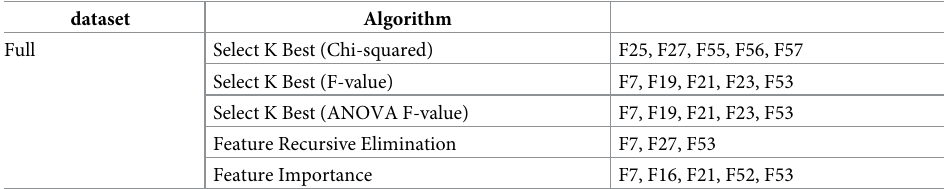
Table 9. Results of feature selection of the spambase